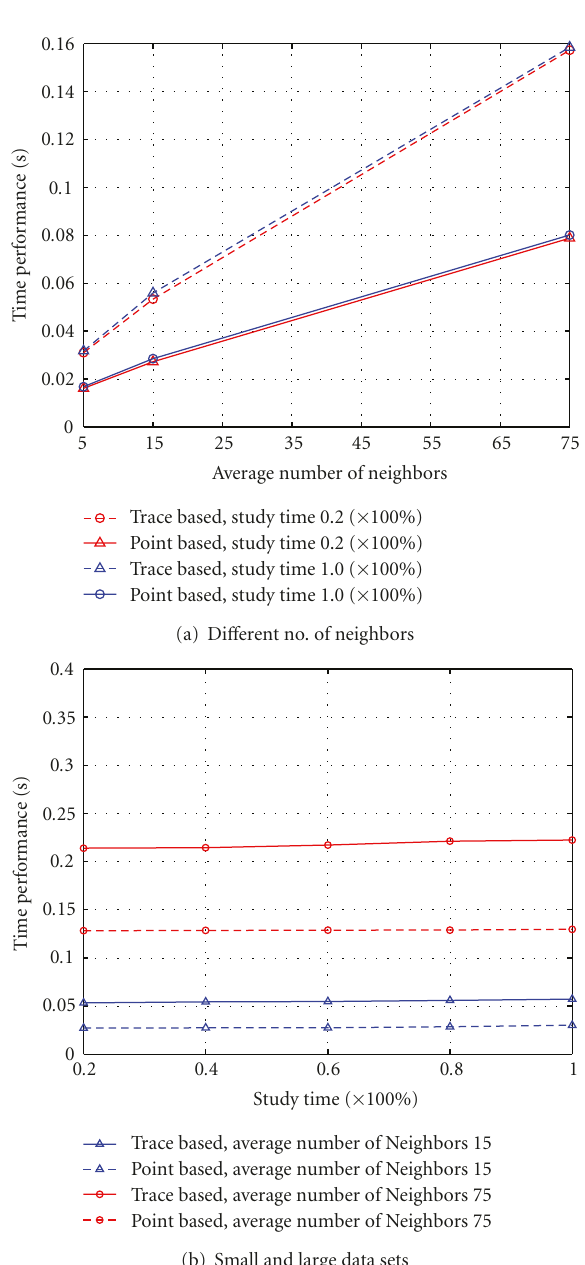
Figure 12: Comparison of time measurements between point- based and trace-based schemes in walking scenario under di ff erent conditions: (a) di ff erent average number of neighbors using the small data set; (b) comparison between small and large data